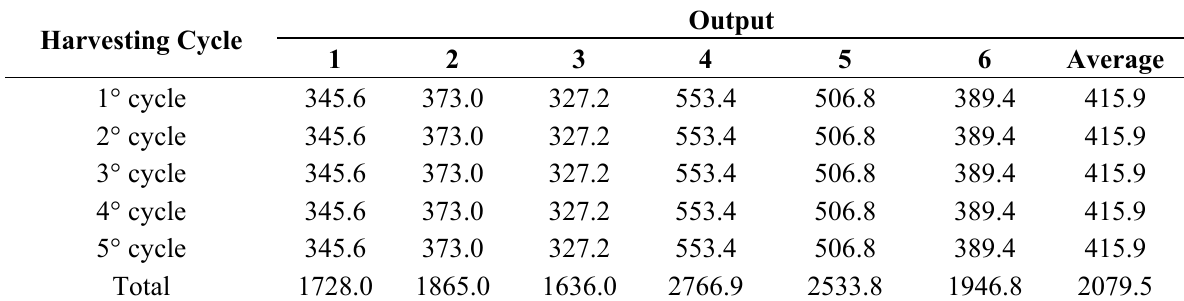
Table 7. Energetic outputs of total productive cycle of plantation (GJ·ha − 1 ) (1: Clone AF2, single row; 2: Clone AF6, single row; 3: Clone Monviso, single row; 4: Clone AF2, twin rows; 5: Clone AF6, twin rows; 6: Clone Monviso, twin rows).